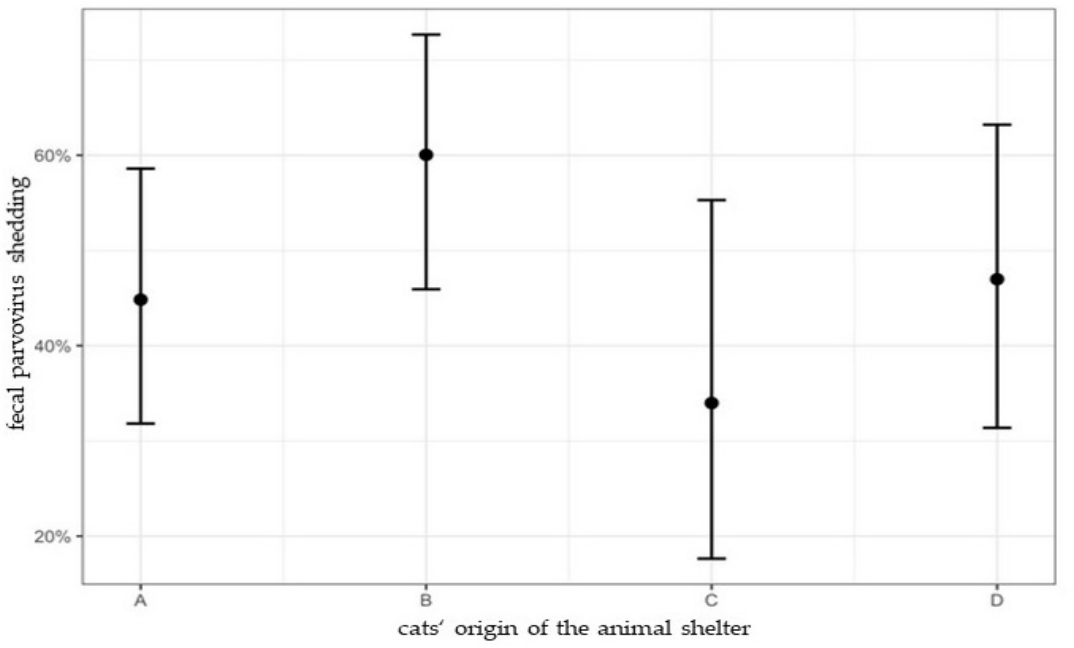
Figure 2. Percentage of cats with fecal parvovirus shedding in shelter A, B, C, and D with 95% con- fidence intervals. In shelter A, 44.8% (95% CI: 31.8–58.6%) of cats, in shelter B, 60.0% (95% CI: 45.9– 72.7%) of cats, in shelter C, 34.0% (95% CI: 17.6–55.3%) of cats, and in shelter D, 47.0% (95% CI: 31.4– 63.2%) of cats had fecal parvovirus shedding. Fecal parvovirus shedding was detected in shel-